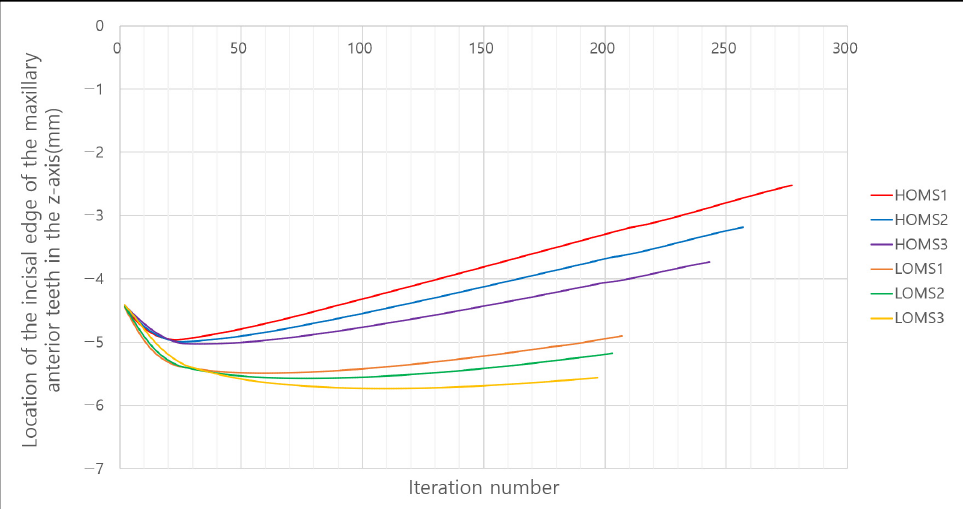
Figure 6. Vertical position of maxillary central incisor edge.